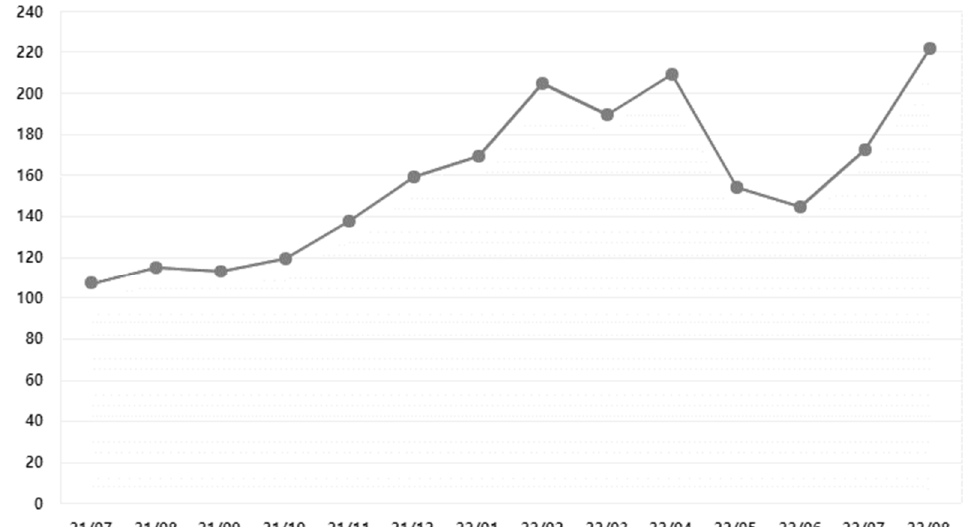
Figure 9. The trend of the weighted average of SMP on Jeju Island for a recent year * [17]. * x -axis: Year/Month, y -axis: SMP Average (KRW/kWh).